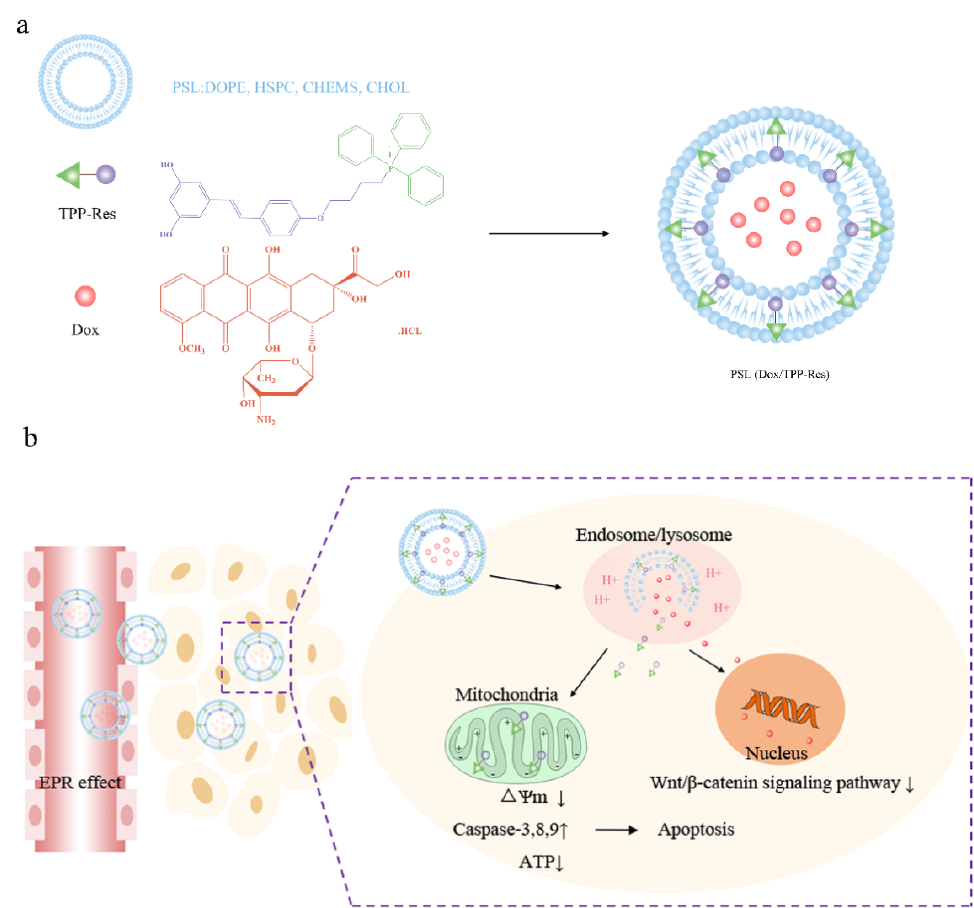
Figure 1. ( a ) Schematic of PSL (Dox/TPP-Res) composed of pH-sensitive liposome encapsulated with Dox and TPP-Res. ( b ) Schematic illustration of the hierarchical targeting strategy by PSL (Dox/TPP-Res) to reverse chemotherapeutic resistance in cancer stem-like cells.